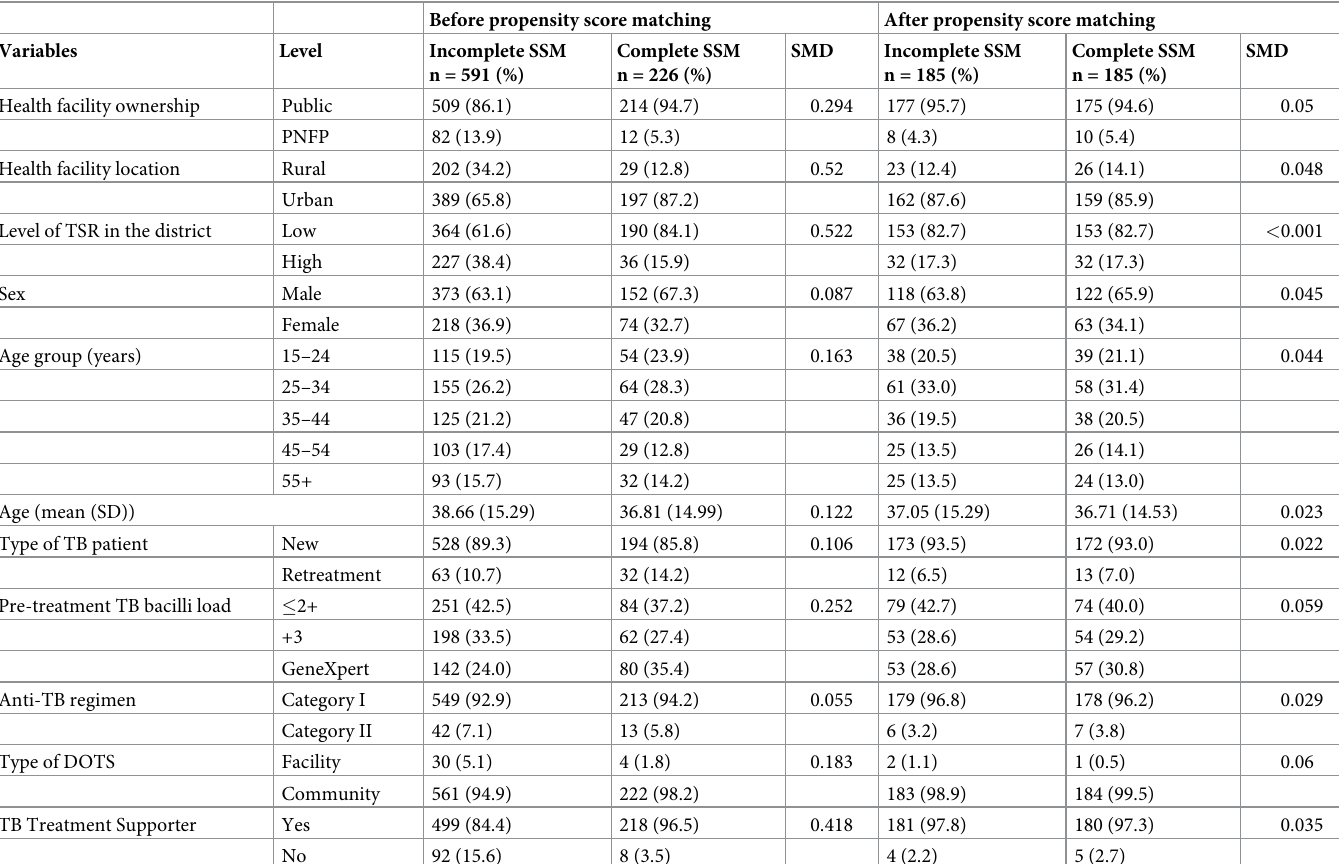
Table 1. Patient characteristics before and after propensity score